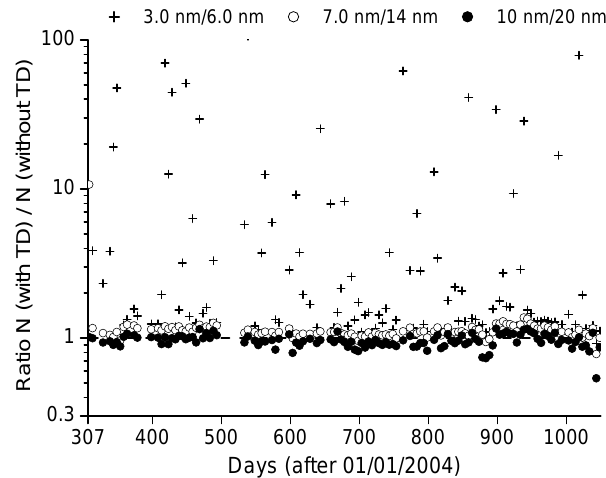
Fig. 2. Ratio between the total particle number concentrations up- stream and downstream the thermodenuder. The labels indicate the pairs of lower threshold diameters that were applied to the non- conditioned and conditioned size distributions, respectively, before computing the integral number concentration. Time is coded in days after 01 January 2004. Plotted is every fifth daily average value of the measurement